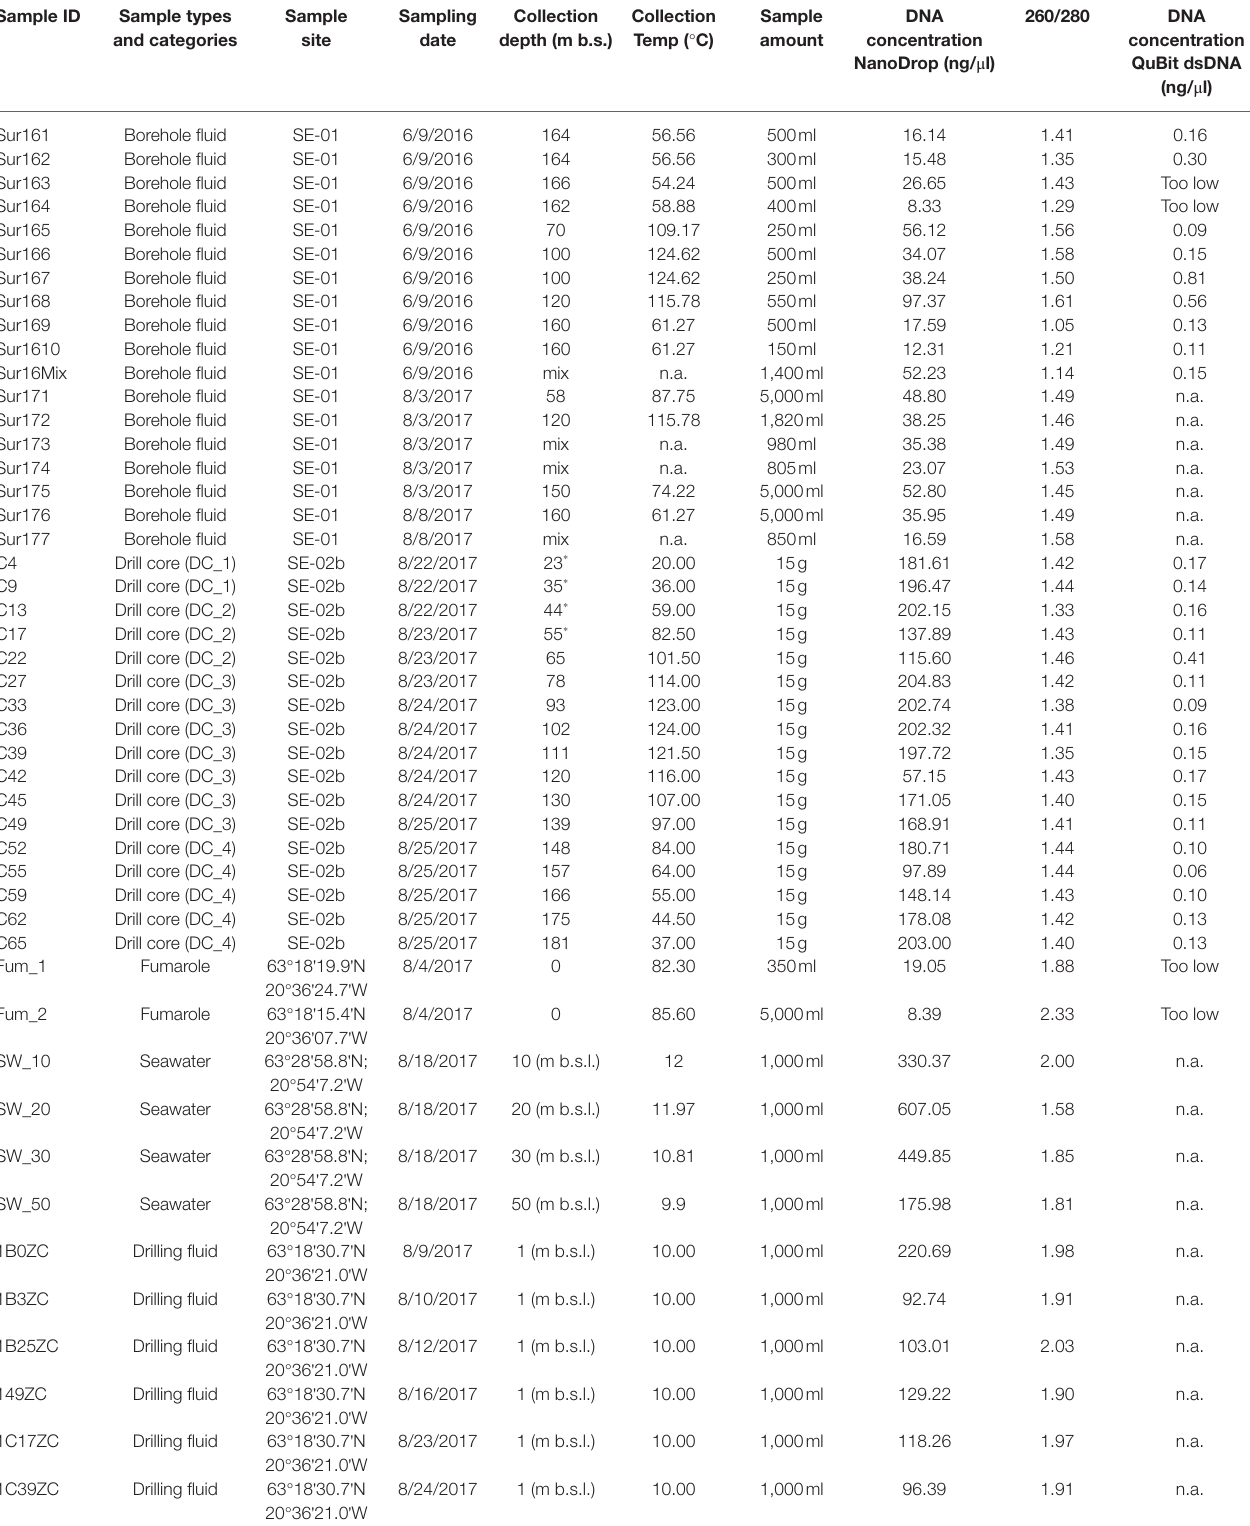
TABLE 1 | Sample description table: locations, sampling date, depth, temperature, and DNA